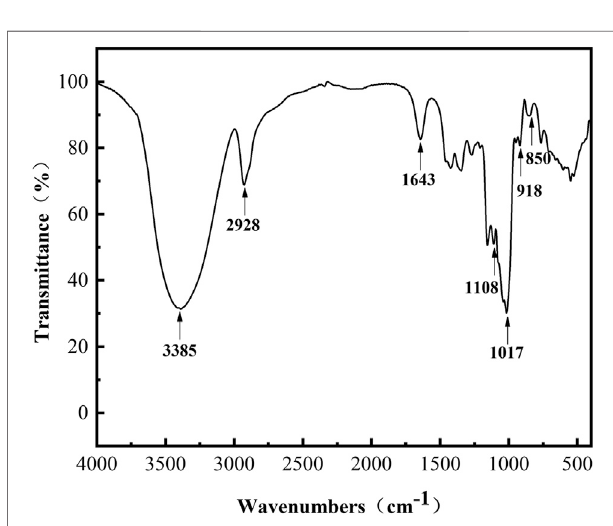
FIGURE4| FT-IRspectraofpuri fi edL-dextransynthesizedbymutantQ634A.